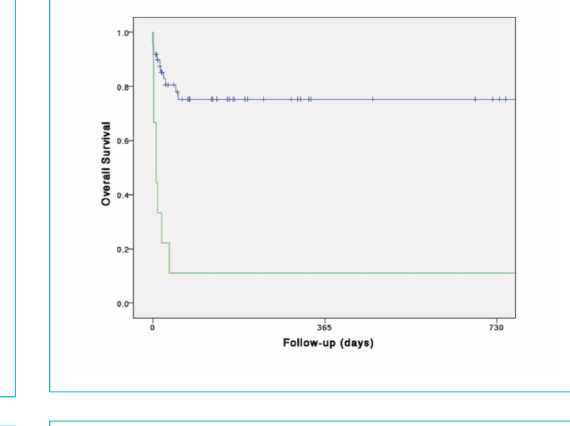
Figure 2B: Kaplan-Meier cumulative survival curves grouped by diagnosis: blue graph cardiogenic shock (CS, n = 22) and green graph acute respiratory distress syndrome (ARDS, n = 36). Four patients with combined cardiopulmonary failure were assigned to the CS group. Log-rank (Mantel Cox) test: p = 0.001.